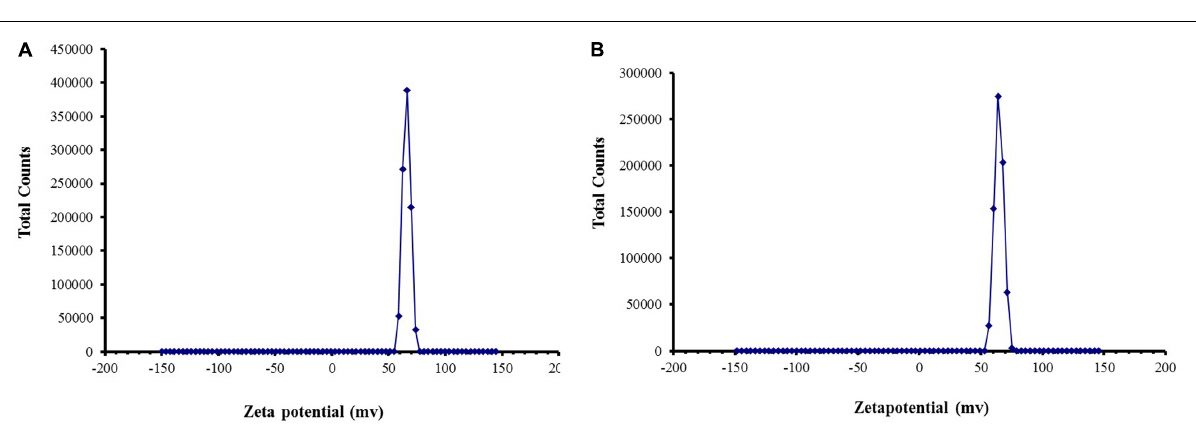
FIGURE 3 | Fourier transform infrared spectroscopic (FTIR) spectra of (A) CS raw material, (B) cardamom oil raw material, (C) blank CSNPs, and (D) cardamom oil-loaded CSNPs. From these images it can be observed that the FTIR image of CSNPs and EOs loaded CSNPs are almost superimposable, indicating no chemical reaction between CS and EOs. The entrapment of EOs is mere physical.